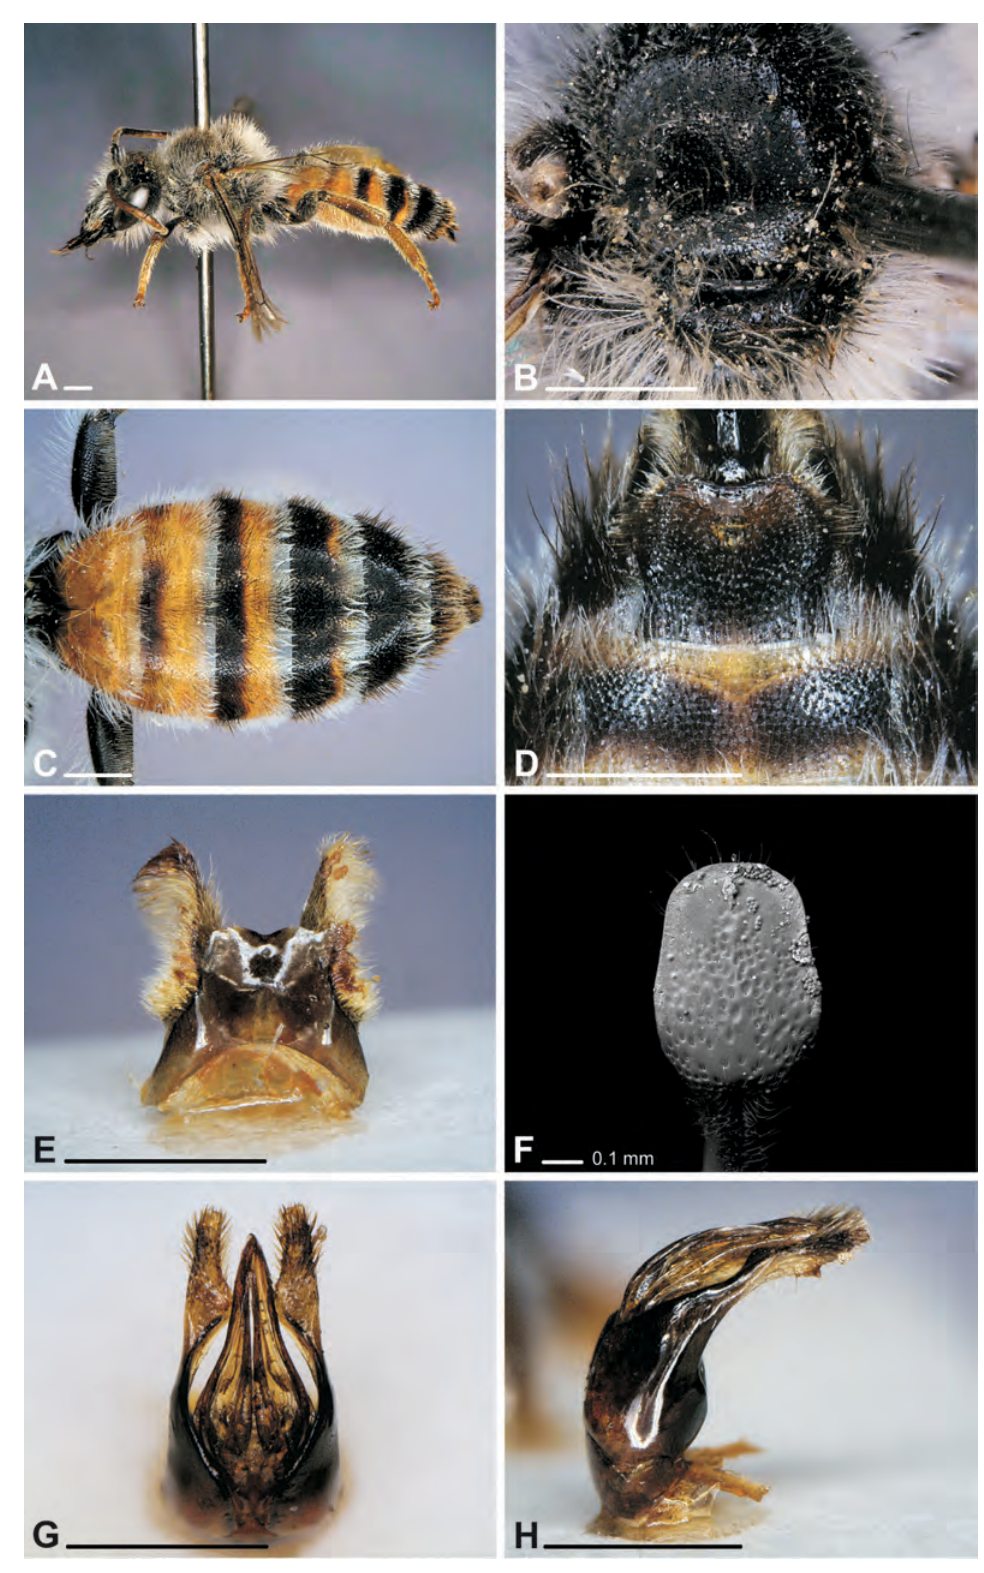
Fig. 13. Redivivoides simulans Michener, 1981, ♂. A . lateral view. B . Scutum and scutellum. C . Metasoma (dorsal view). D . S6 (ventral view). E . S7 (dorsal view). F . S8, apical end (backscattered electron image). G . Genitalia (dorsal view). H . Genitalia (lateral view). Scale bar: 1